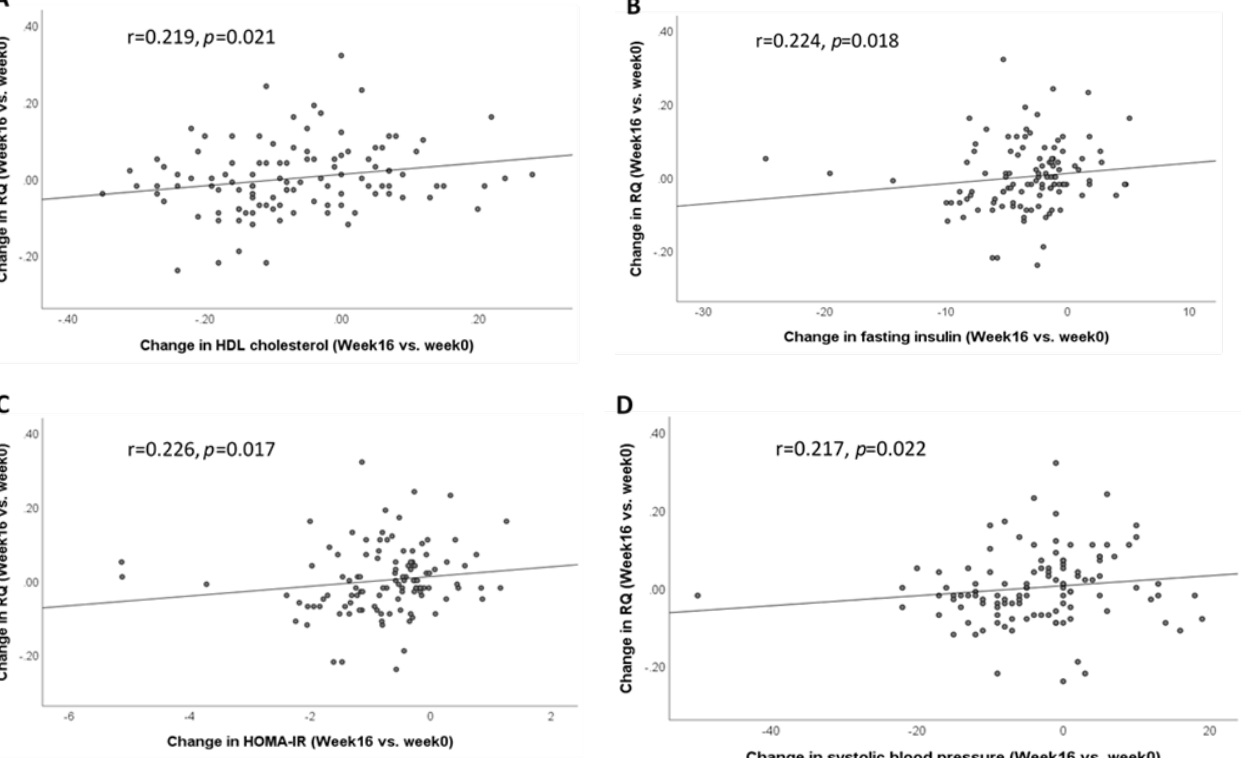
Figure 2. Correlation between the change in RQ and the change in metabolic measures after 16 weeks of dietary weight loss intervention (week 16 vs. week 0). ( A ) Correlation between the change in RQ and the change in HDL cholesterol; ( B ) correlation between the change in RQ and the change in fasting insulin; ( C ) correlation between the change in RQ and the change in HOMA-IR; ( D ) correlation between the change in RQ and the change in systolic blood pressure. Data were analyzed by Spearman’s correlation. Abbreviations: high-density lipoprotein, HDL; homeostatic model assessment of insulin resistance, HOMA-IR; respiratory quotient, RQ.